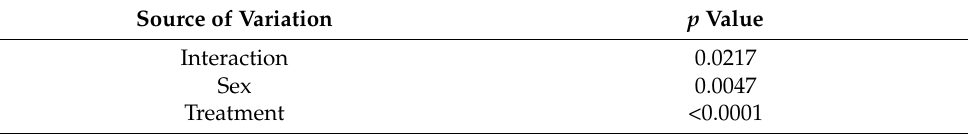
Table 4. Statistical table of the individual effects and interactions of rat sex and treatment on serum SOD